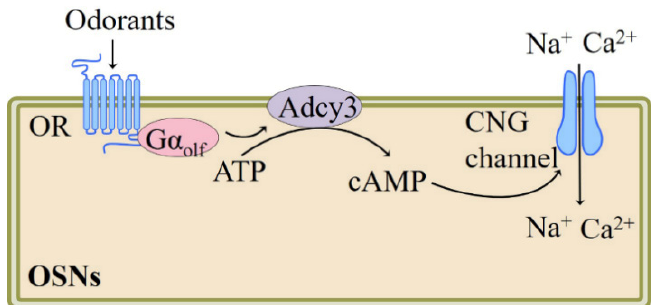
Figure 1. Schematic model of the olfactory signaling transduction pathways in OSNs, adapted from [3,23], published by Cell Press, 1991 and Annual Reviews, 2002. Adcy, adenylyl cyclase; cAMP, cyclic adenosine monophosphate; CNG, cyclic nucleotide gated channel; G α olf , olfactory G protein alpha